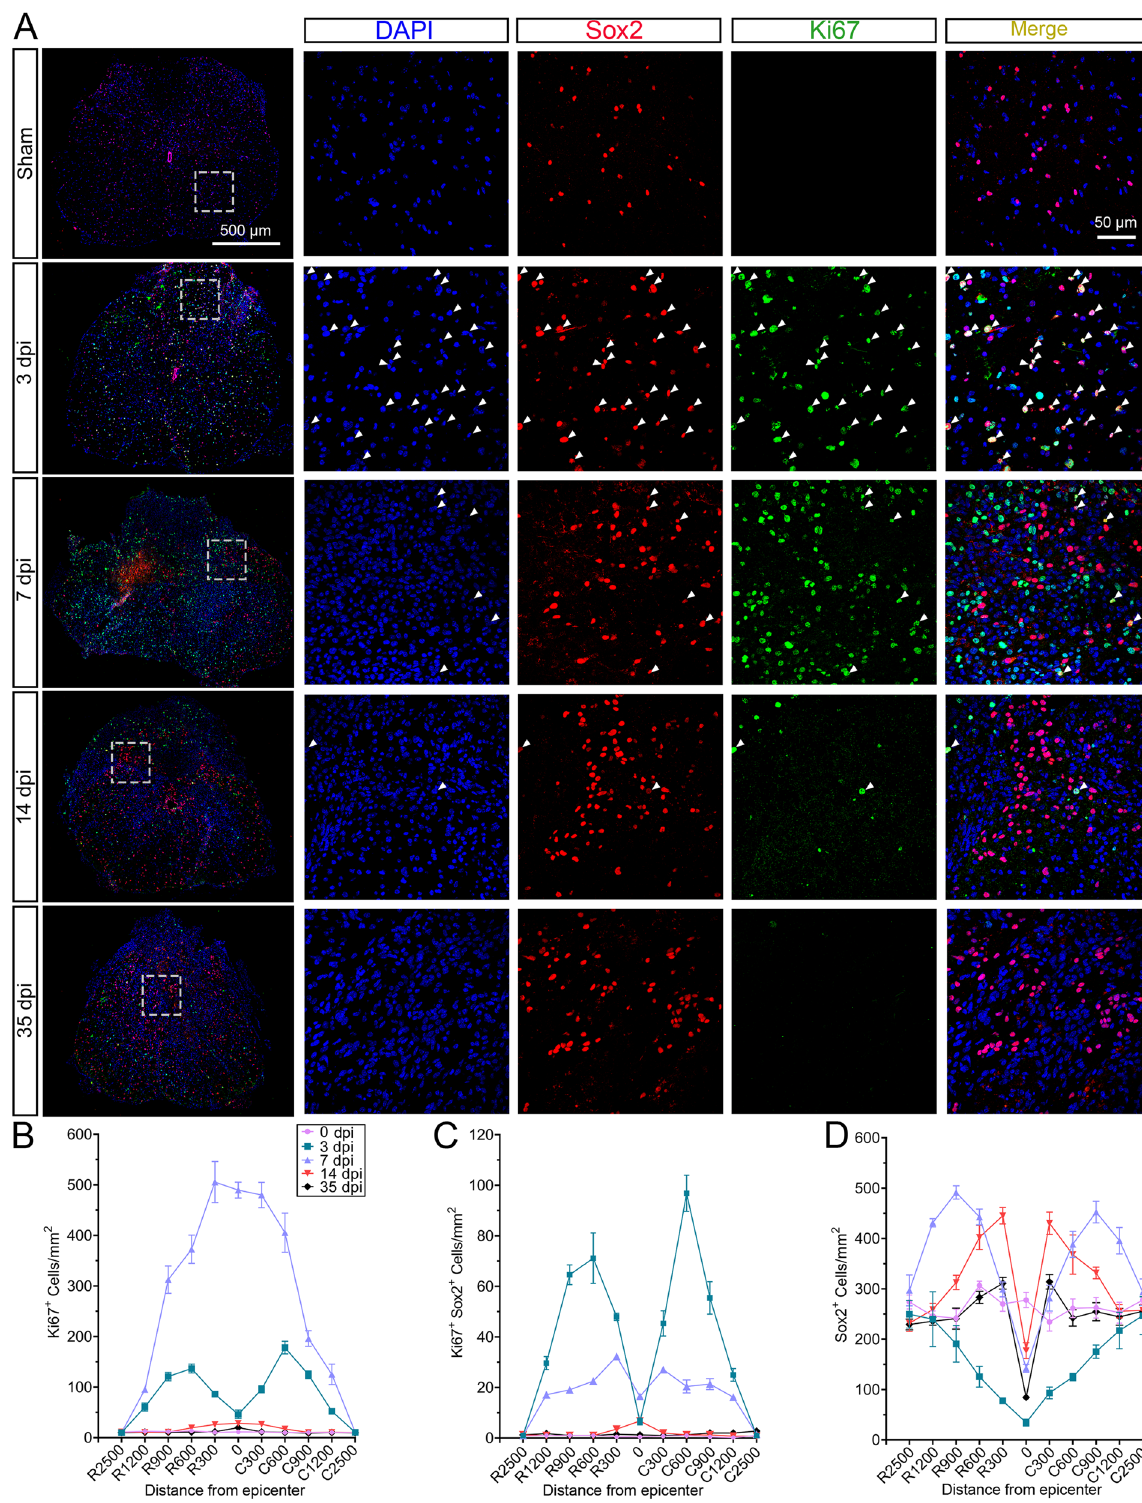
Fig. 5 NSCs extensively proliferated within the lesion rim after SCI in mice. A Immunofluorescence staining showing the spatiotemporal distribution of NSCs (Sox2 + , red) and proliferating cells (Ki67 + , green) in the sham group, as well as within the lesion rim at 3, 7, 14, and 35 dpi. n 4. Scale bar: 500 μm or 50 μm. B Quantification of the total number of proliferative cells per mm 2 of tissue. C Quantification of the total number of proliferative NSCs per mm 2 of tissue. D Quantification of the total number of NSCs per mm 2 of